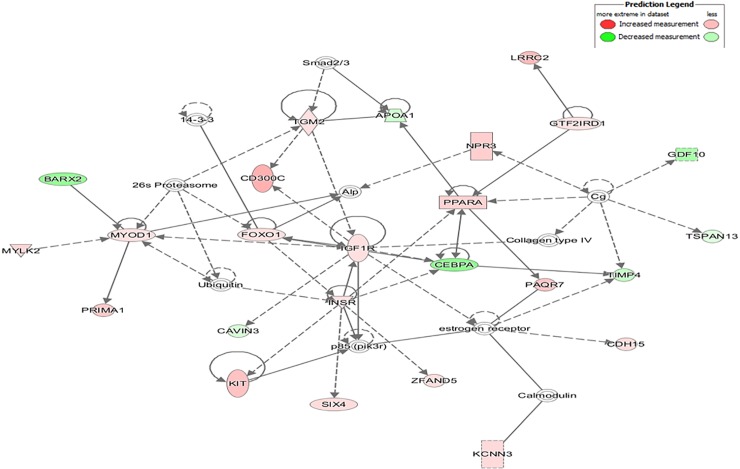
Functional network of Metabolic Disease, Cellular Movement, as well as Skeletal and Muscular System Development and function identified by analysis of DE genes in Iberian and crossbred fetuses.The intensity of colors represents the magnitude of differential expression, with red indicating genes upregulated in crossbred fetuses, while green indicates those upregulated in Iberian fetuses. Direct interactions are represented by solid lines, while indirect interactions are represented by dashed lines. The shapes of the nodes reflect the functional class of each gene product: transcriptional regulator (horizontal ellipse), transmembrane receptor (vertical ellipse), enzyme (vertical rhombus), cytokine/growth factor (square), kinase (inverted triangle) and complex/group/other (circle).